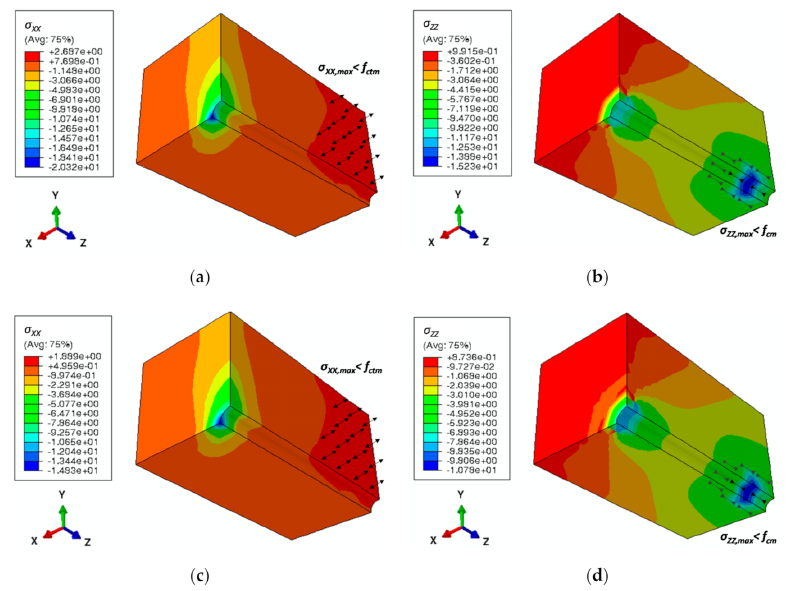
Figure 7. Numerical ( a ) tensile and ( b ) compressive stress fields of RC and ( c ) tensile and ( d ) compressive stress fields of C100F-Vim at the corresponding instants of maximum bond stress (stress values in